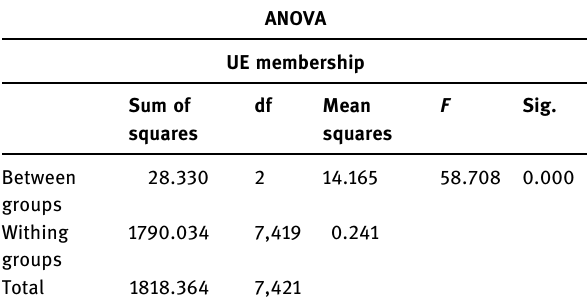
Table 14: Validation test by country